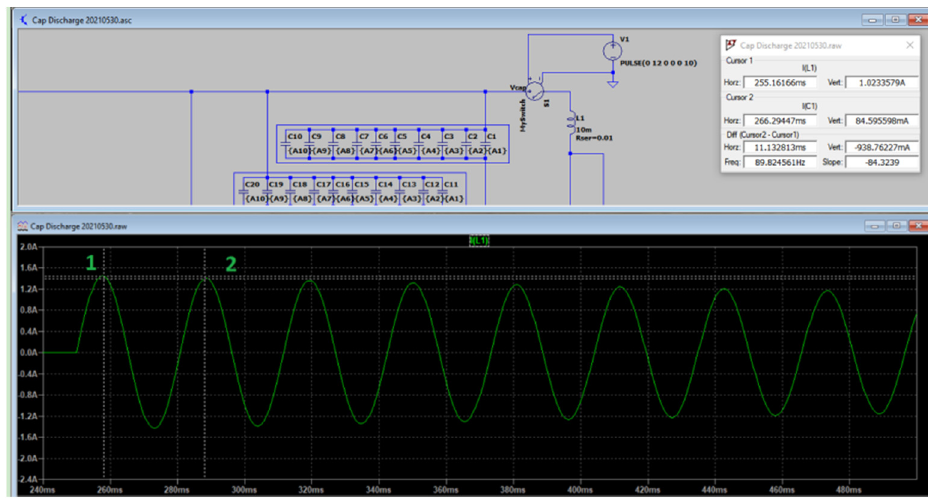
Figure 19. LTSPICE simulation and